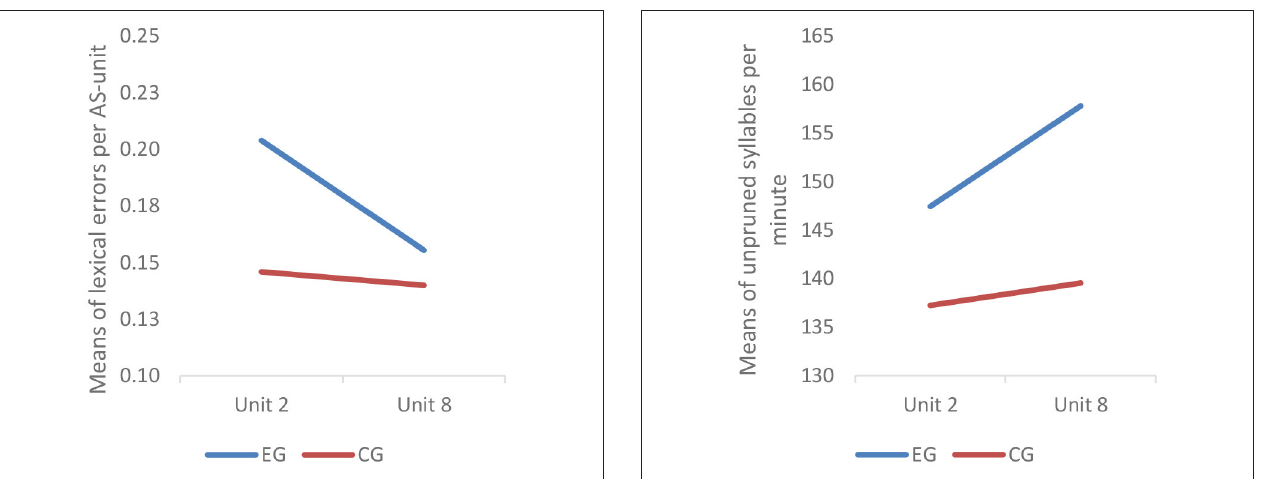
(i.e., G-index, vocd-D and MTLD) and speed fluency. But on